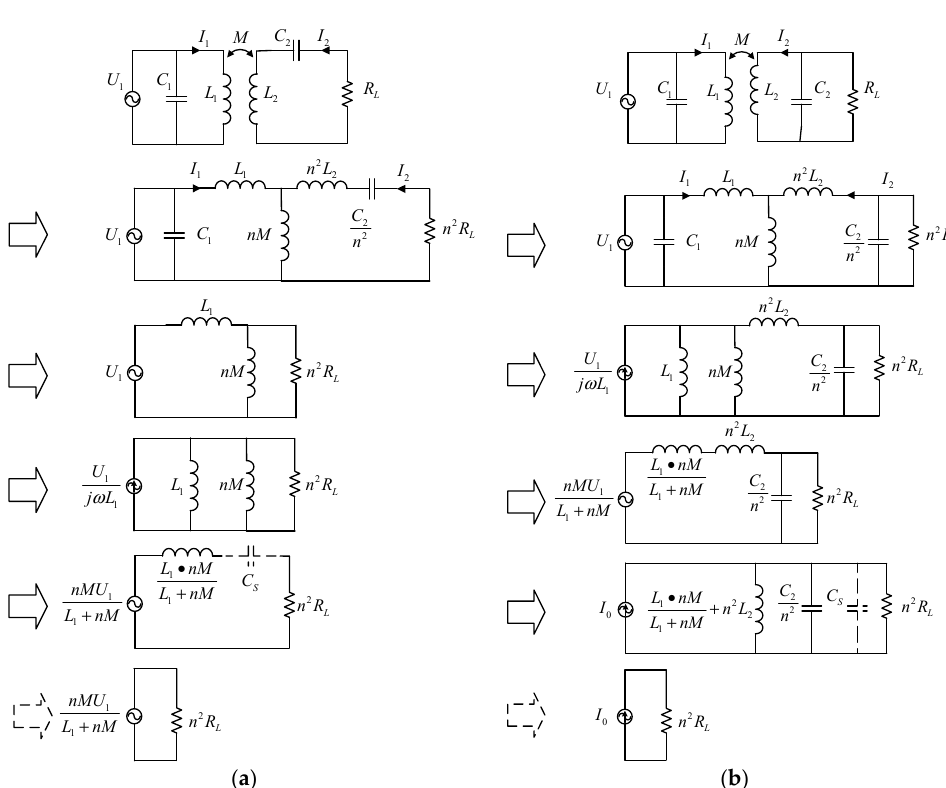
Figure 7. The SP and PP compensation Witricity circuit using the equivalent circuit A. ( a ) The SP compensation Witricity circuit; ( b ) The PP compensation Witricity circuit.